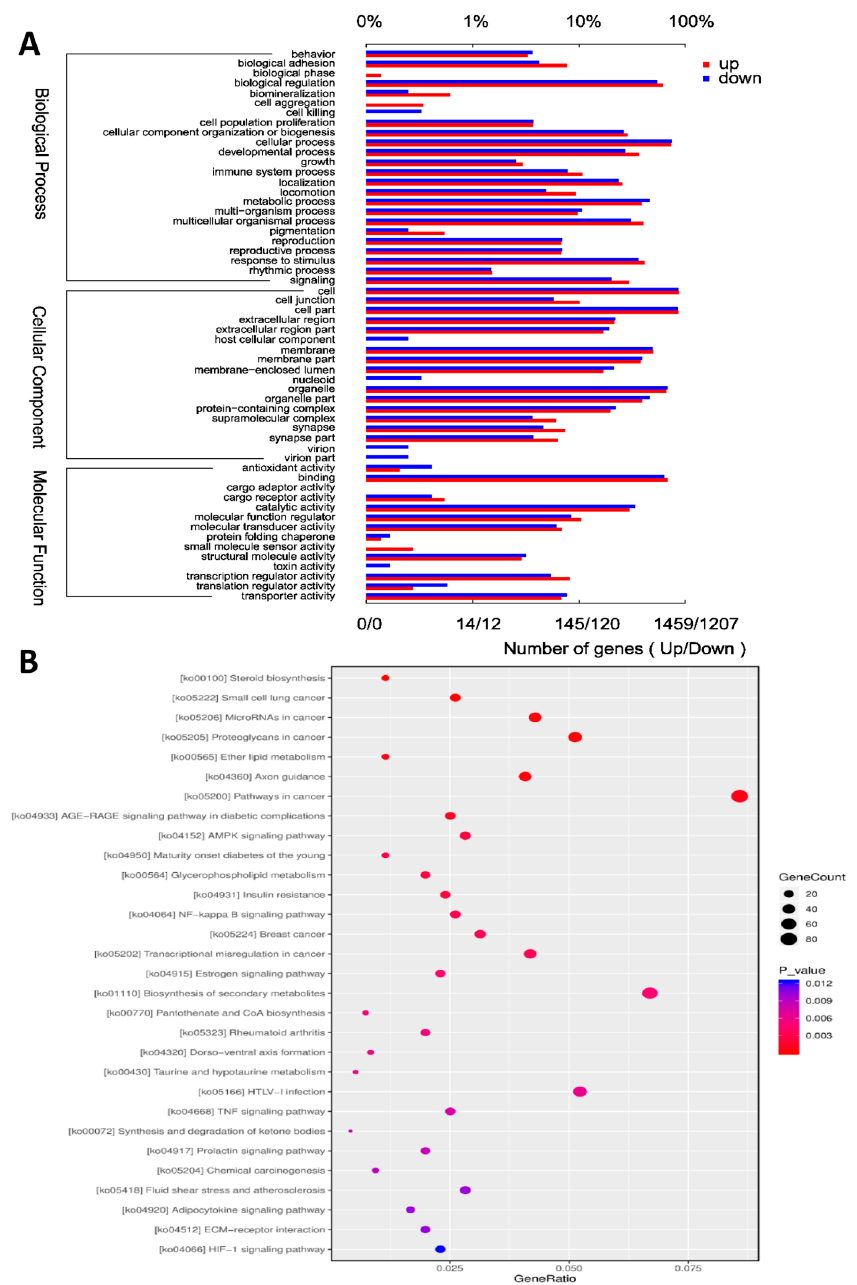
Figure 3. GO and KEGG pathway analyses of DEmRNAs. ( A ) GO analysis of the DE mRNAs. The X axis shows the number of DE genes, and the Y axis shows the GO terms. All GO terms are grouped into biological process, cellular components and molecular function. The red bar represents the number of up-regulated genes, and the blue bar represents the number of down-regulated genes. ( B ) KEGG analysis of the DE mRNAs. In this graphic, the degree of KEGG enrichment is assessed by the GeneRatio, p -value, and GeneCount. The closer the p -value is to zero, the greater the GeneRatio is. The greater the GeneCount is, the more significant the enrichment